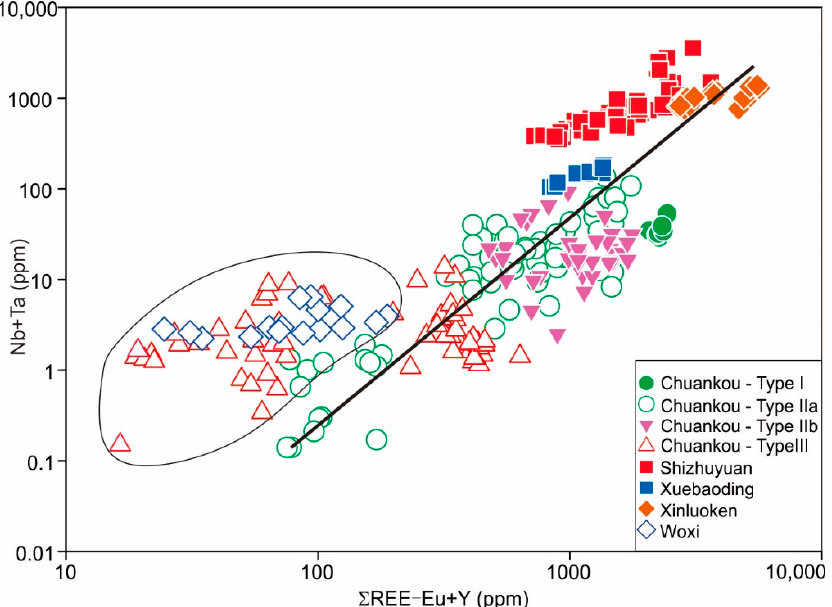
Figure 9. Bivariate diagrams of Σ REE-Eu + Y Vs Nb + Ta of scheelite from the Chuankou tungsten deposit and other deposits for comparison (e.g., Shizhuyuan; Xuebaoding; Xingluokeng; and Woxi). Chondrite values are from Sun and McDonough [39].